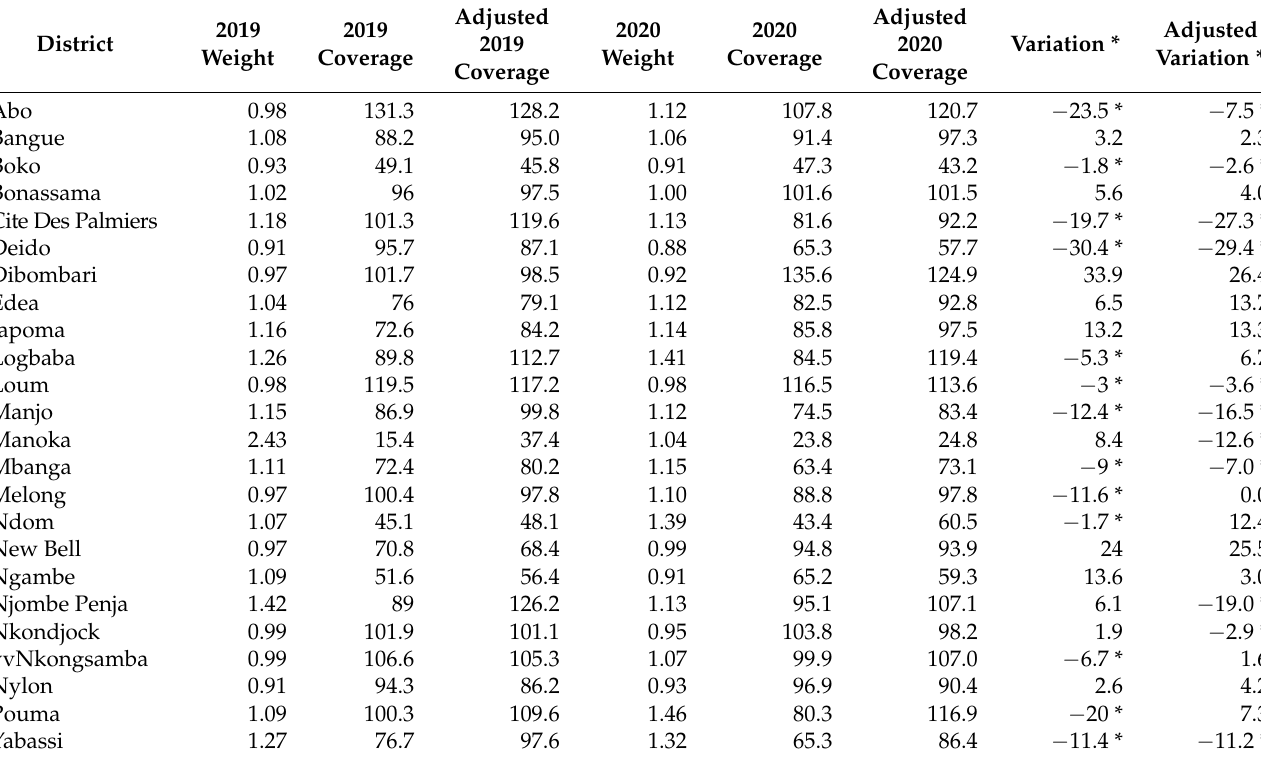
Table 1. DTP-1 coverage variations in the pre-pandemic and pandemic period in the Littoral